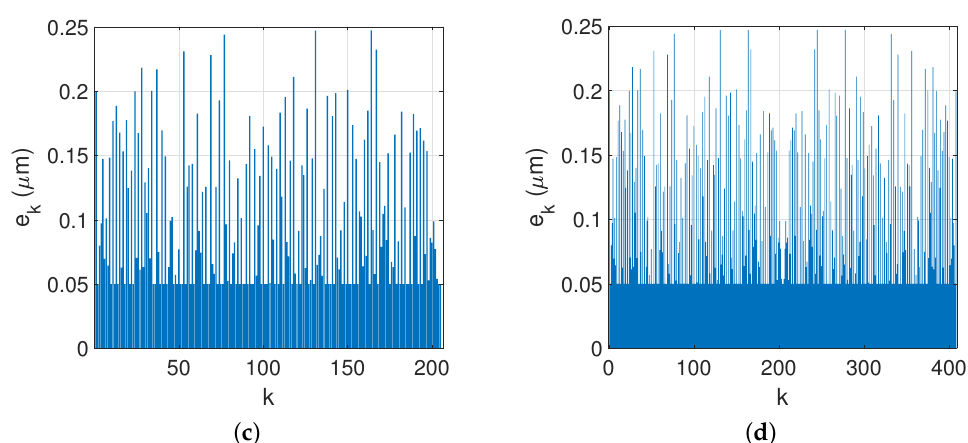
Figure 9. Design of a plasmonic silver-flat-metalens of d = 41 µ m-wide consisting of N p = 248 silver-nanoridges and nanoslits focusing a normal incident TM-polarized plane wave at a wavelength λ = 0.637 µ m at a distance of 15 λ . ( a , b ) presents the cartography of the normalized magnetic field intensity in the plane ( X , O , Z ) . ( c , d ) shows the values of the (nanoridges, nanoslits)-widths sequence [ e k ] k with respect to their locations labelled by k . Numerical parameters: λ = 0.637 µ m, N p = 205, e z = 400 nm, TM polarization. ( a ) d = 20.55 µ m; ( b ) d = 41 µ m; ( c ) n p = 205; ( d ) N p = 408 = 205 + ( 205 − 2 ) .